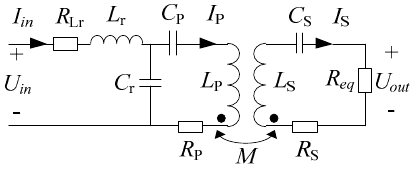
Figure 5. LCC compensation equivalent circuit.